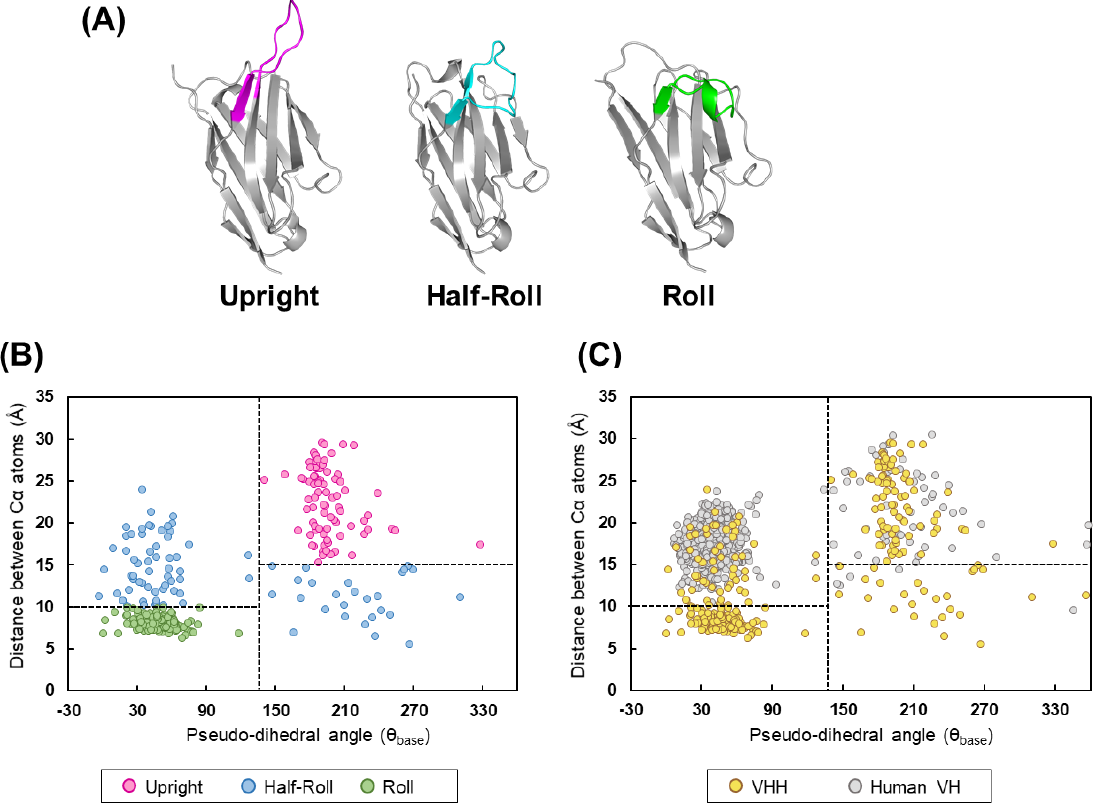
Figure 1. Classification of VHHs by CDR3 loop structures. ( A ) The structure of VHHs is classified into three types based on the conformation of CDR3; Upright , Half-Roll and Roll (PDB ID: 5j1s, 6ru3, and 2p45). ( B , C ) The distances between C α atoms of CDR3 loop and FR2 (distance between H46 residue and (n − 5)th residue with H102 as (n)th residue) and pseudo-dihedral angles of CDR3 C-terminal (dihedral angle consisting of the four C α atoms of the (n+1)th, (n)th, (n − 1)th, and (n − 2)th residues, with H102 as the (n)th residue) were calculated from structures and the value was plotted. ( B ) The structures of CDR3 were classified into the three groups according to type ( Upright , Roll , and Half-roll ) based on the distance and pseudo-dihedral angle. The VHHs belonging in the Upright group (pink dots) had a distance of 15Å or more and an angle of 140° to 360°, the VHHs in the Roll group (green dots) had a distance of 10Å or more and an angle of less than 140°, and the other VHHs were classified as the Half-Roll type (blue dots). ( C ) The CDR3 of human VH (gray dots) from a conventional VH–VL complex and VHH (yellow dots) are shown.